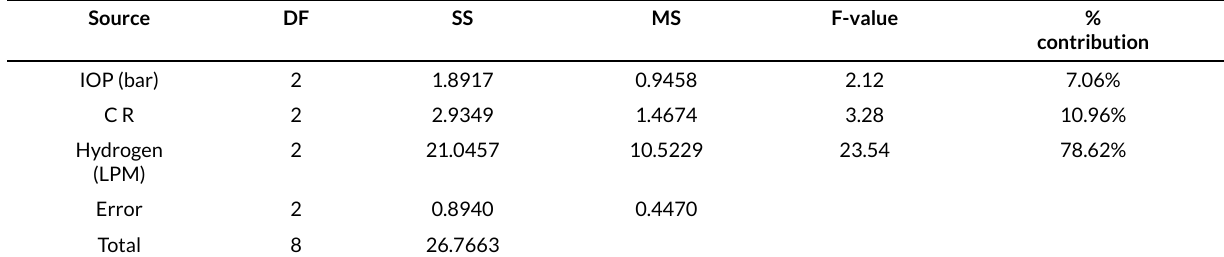
TABLE 7. ANOVA OF UTILITY S/N